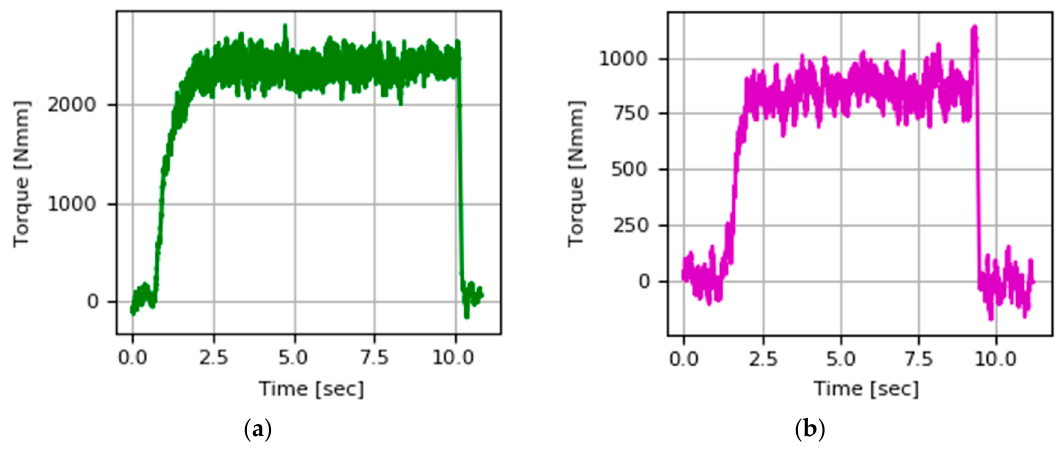
Figure 11. Torque signal during cutting PAW-WAAM wall with (ap=0.5 mm, ae=0.4 mm, fz=0.12 mm/tooth) at different cutting velocities: ( a ) Vc=50 m/min, ( b ) Vc=60 m/min.